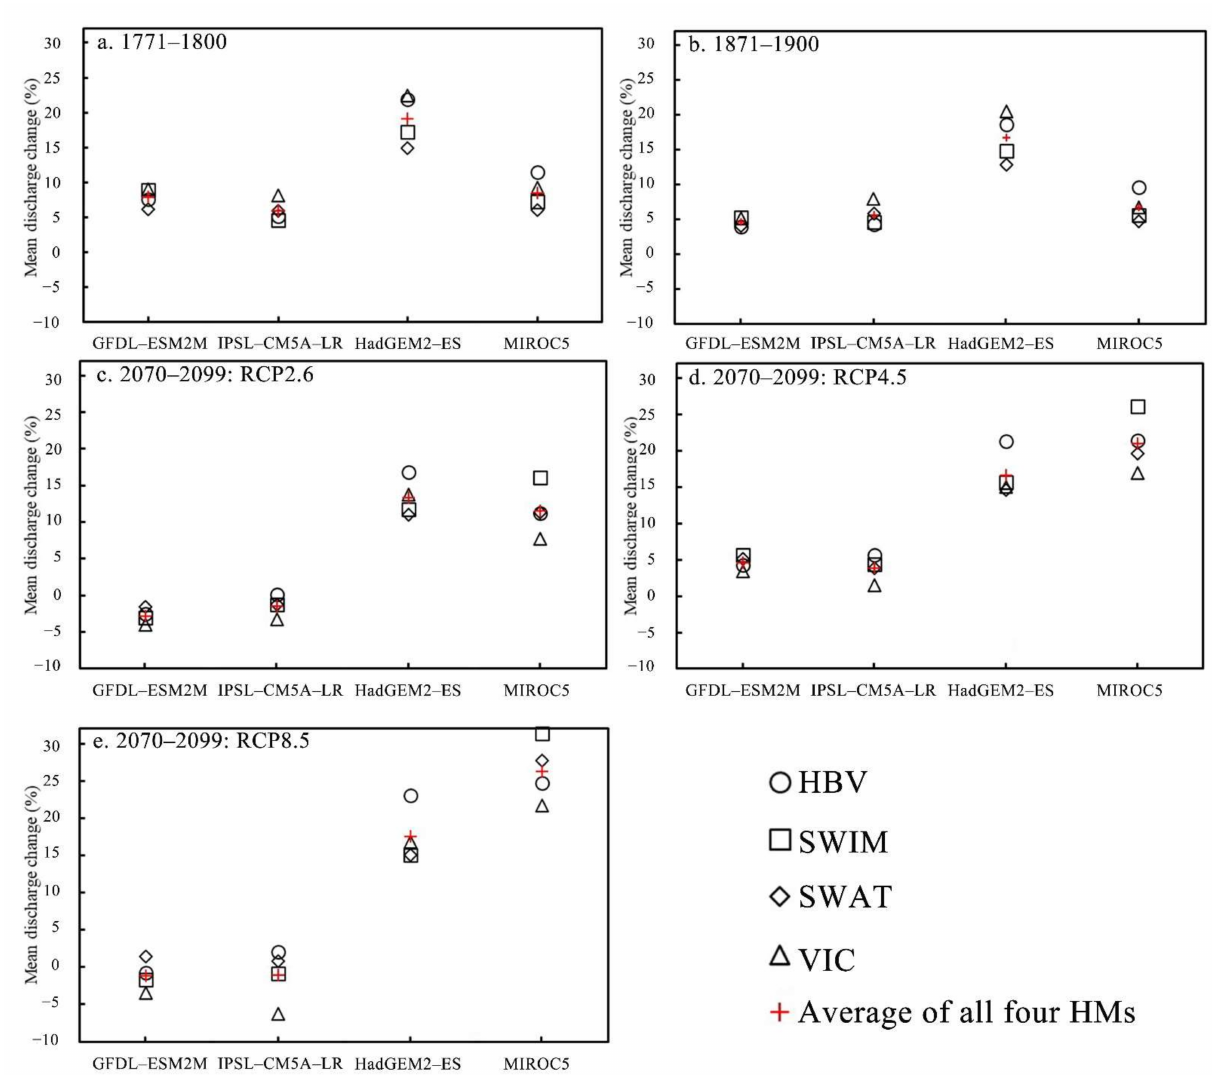
Figure 5. Percentage changes in mean discharge (%) from each of the four hydrological models (HMs) forced by each four GCMs during all time periods relative to the reference